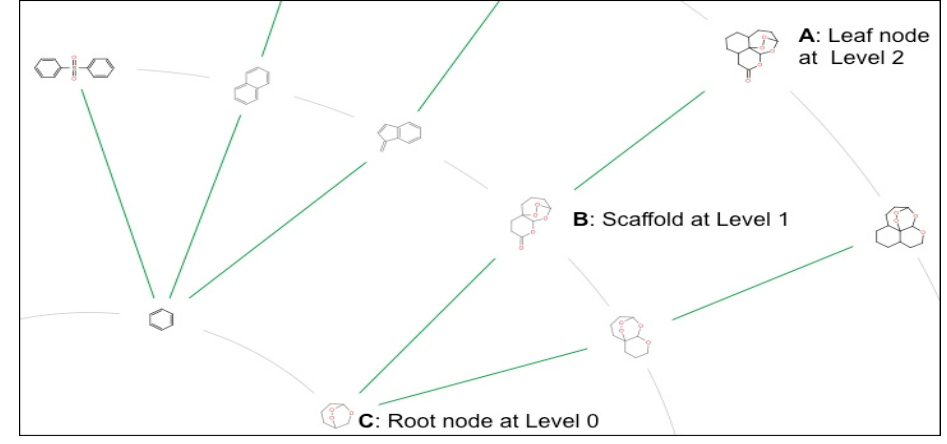
Figure 8. A section of a Scaffold Tree generated with Scaffold Hunter for currently registered antimalarial drugs (complete scaffold tree available in Figure S2). The technique first prunes all terminal side chains from parent molecules ( A ); then iteratively removes rings one by one according to a set of prioritization rules from the parent molecule (A) to get the intermediate scaffold ( B ); At the end, the scaffold with only one ring ( C ) is obtained. Scaffolds B and C represent “virtual scaffolds” that may have bioactivities similar to or higher than the parent compound ( A ).